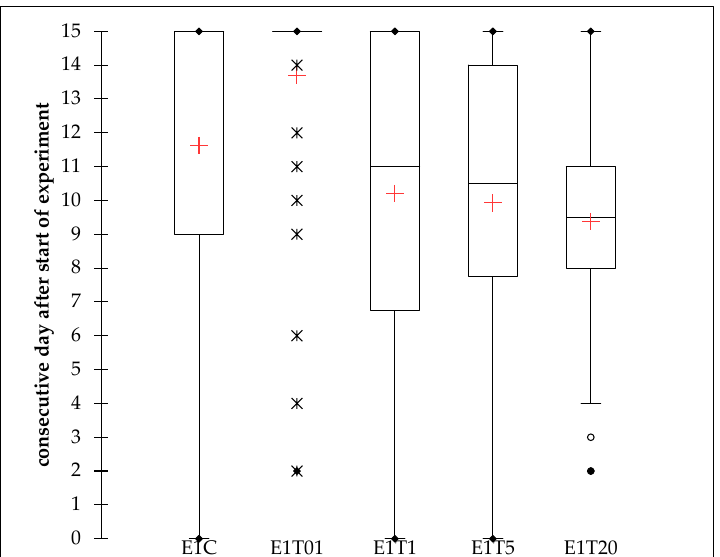
Figure 2. Histogram of mean lethal time for treatments in experiment one with denoted affiliation to groups according to Tukey multiple pairwise comparison.